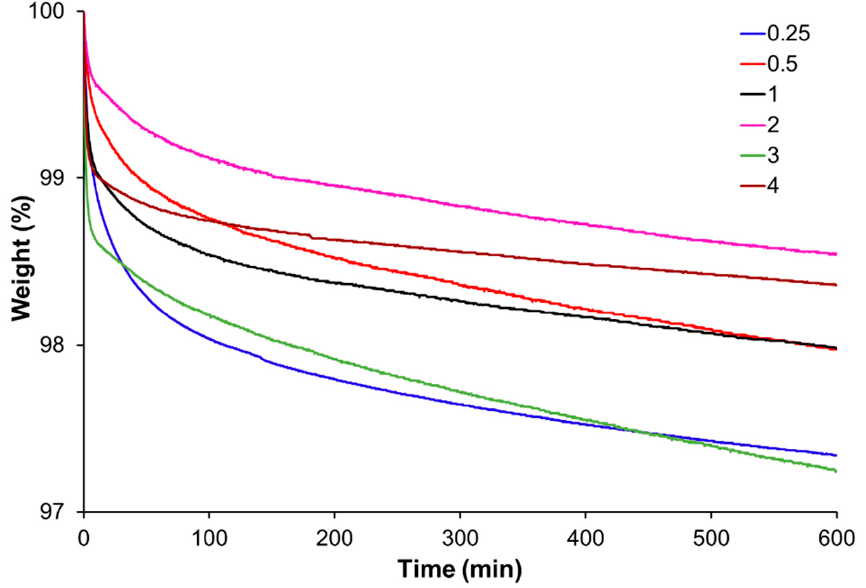
Figure 2. Remaining weight of formulations with varying acrylate:epoxy ratios treated at 180 °C.